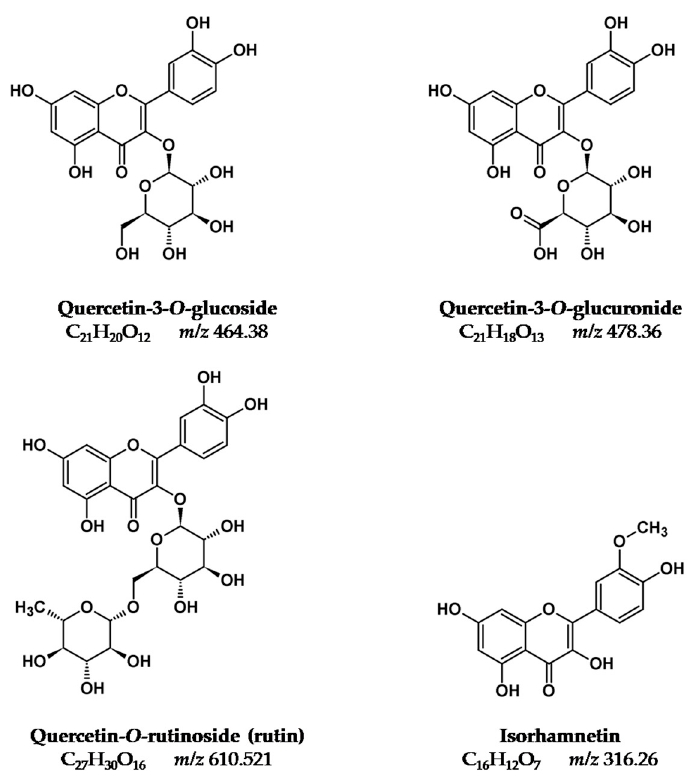
Figure 2. Quercetin-based chromophores (flavonols).